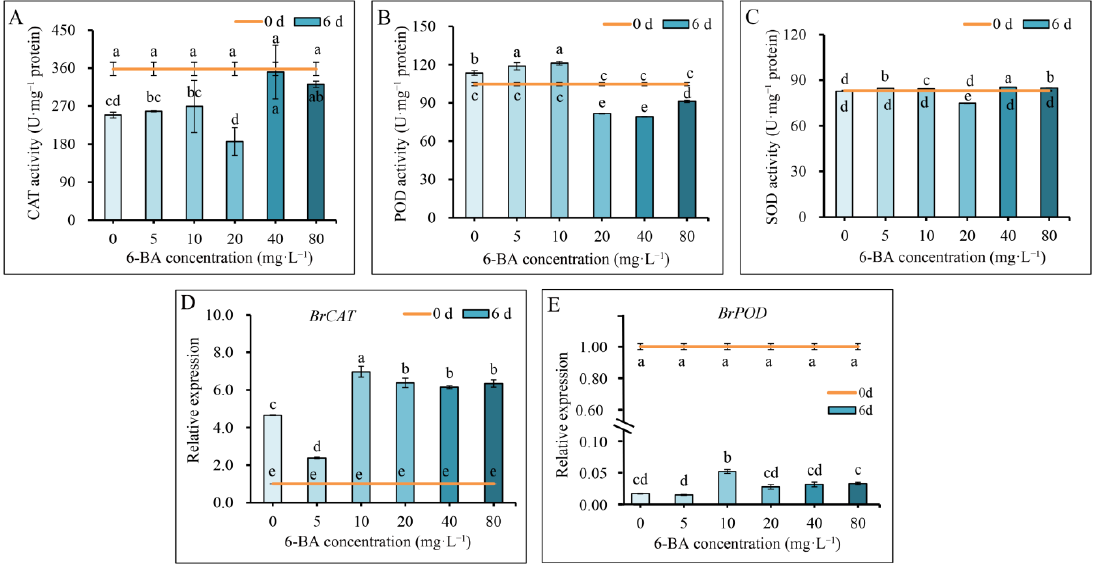
Figure 4. Postharvest 6-BA treatment regulates antioxidant enzyme activities of Chinese flowering cabbage during storage. Effect of postharvest 6-BA treatments on CAT, POD, and SOD activities ( A – C ) and the relative expression of BrCAT and BrPOD genes ( D , E ) of Chinese flowering cabbage. Each bar indicates the mean ± standard deviation of three biological replicates, and different lowercase letters indicate significant differences between Chinese flowering cabbage under different treatments ( p < 0.05).